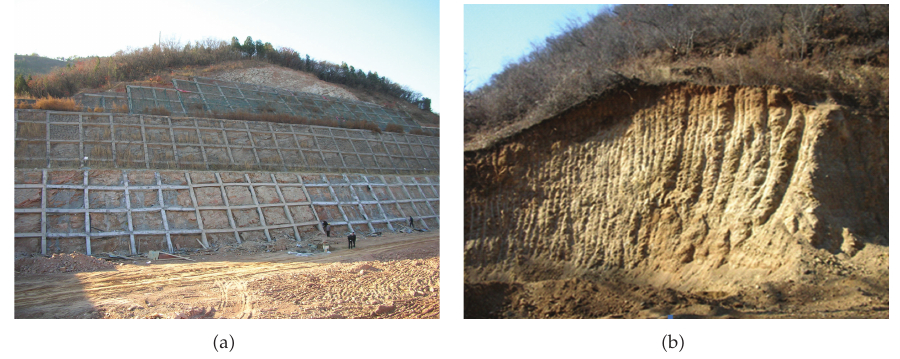
Figure 6: Location of slope and brief geological